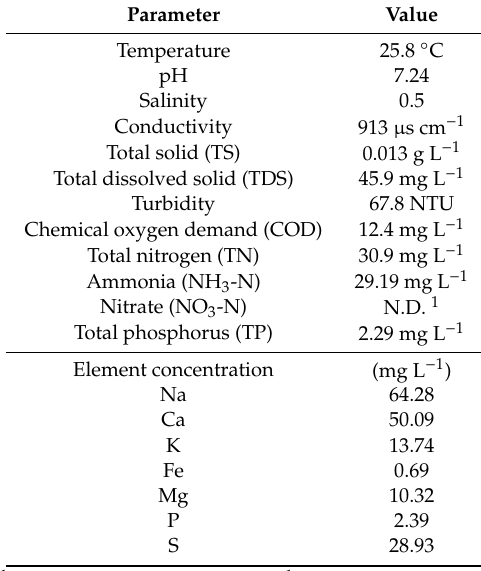
Table 1. General characteristics of primary settled wastewater from Seo-bu Municipal Wastewater Treatment